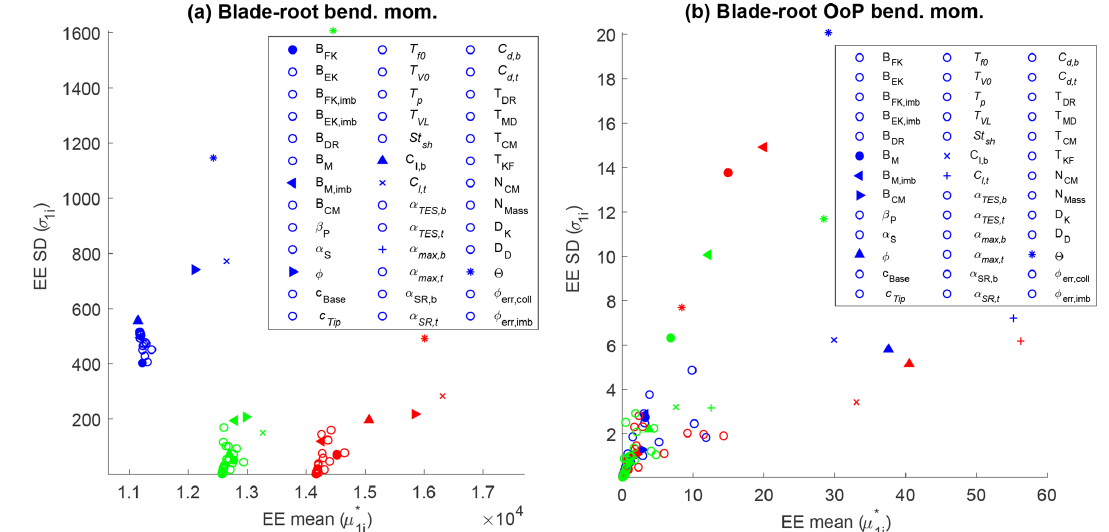
Figure A2. EE standard deviation versus EE mean for blade-root bending moment ultimate load (a) and blade-root Oop bending moment fatigue load (b) at all wind speed bins (blue is below-rated speed, red is near-rated speed, green is above-rated speed).